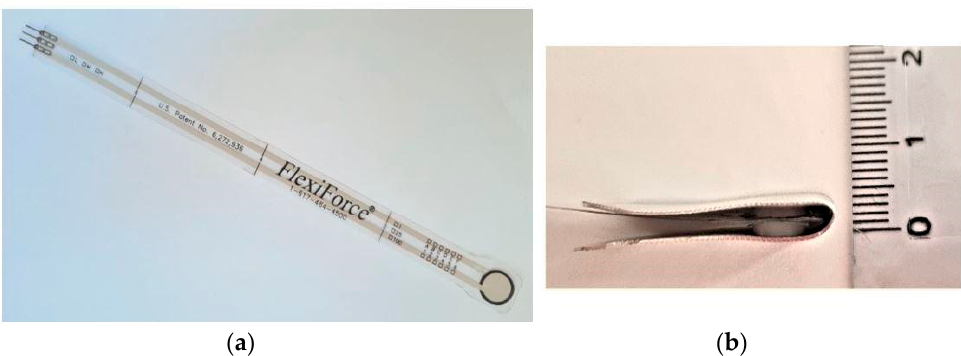
Figure 2. ( a ) FlexiForce ® piezoresistive sensor. ( b ) The designed housing with the thermo-molded discs covered with an aluminum sheet.